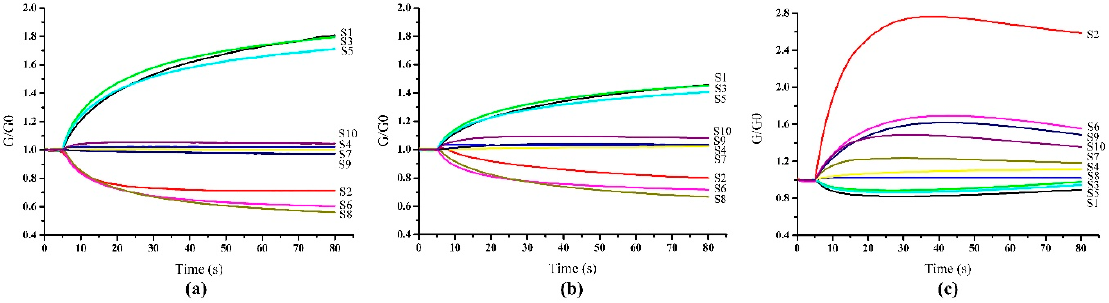
Figure 1. Typical response signals of E-nose system during the ripening process: ( a ) day 0; ( b ) day 4; ( c ) day 7.